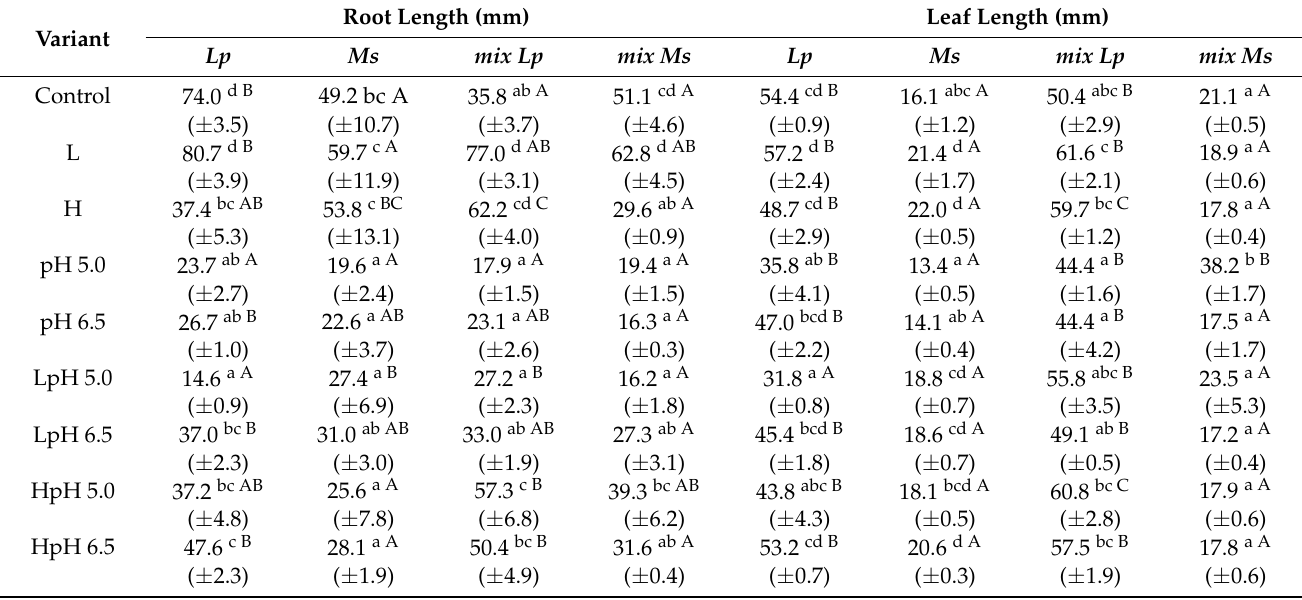
Table 7. Effects of different variants of Medicago sativa root extracts and pH of the solution on the root and leaf length of Lolium perenne ( Lp ) and Medicago sativa ( Ms )